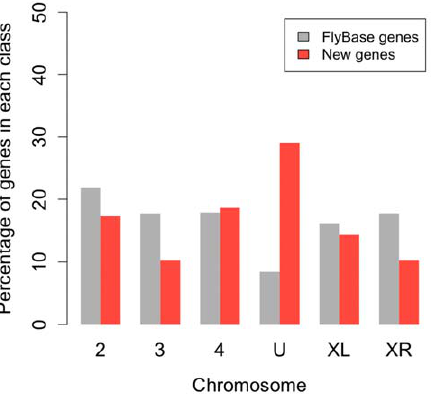
Figure 3. Chromosomal distribution of new genes. Most of the new genes are located on the unassembled contigs